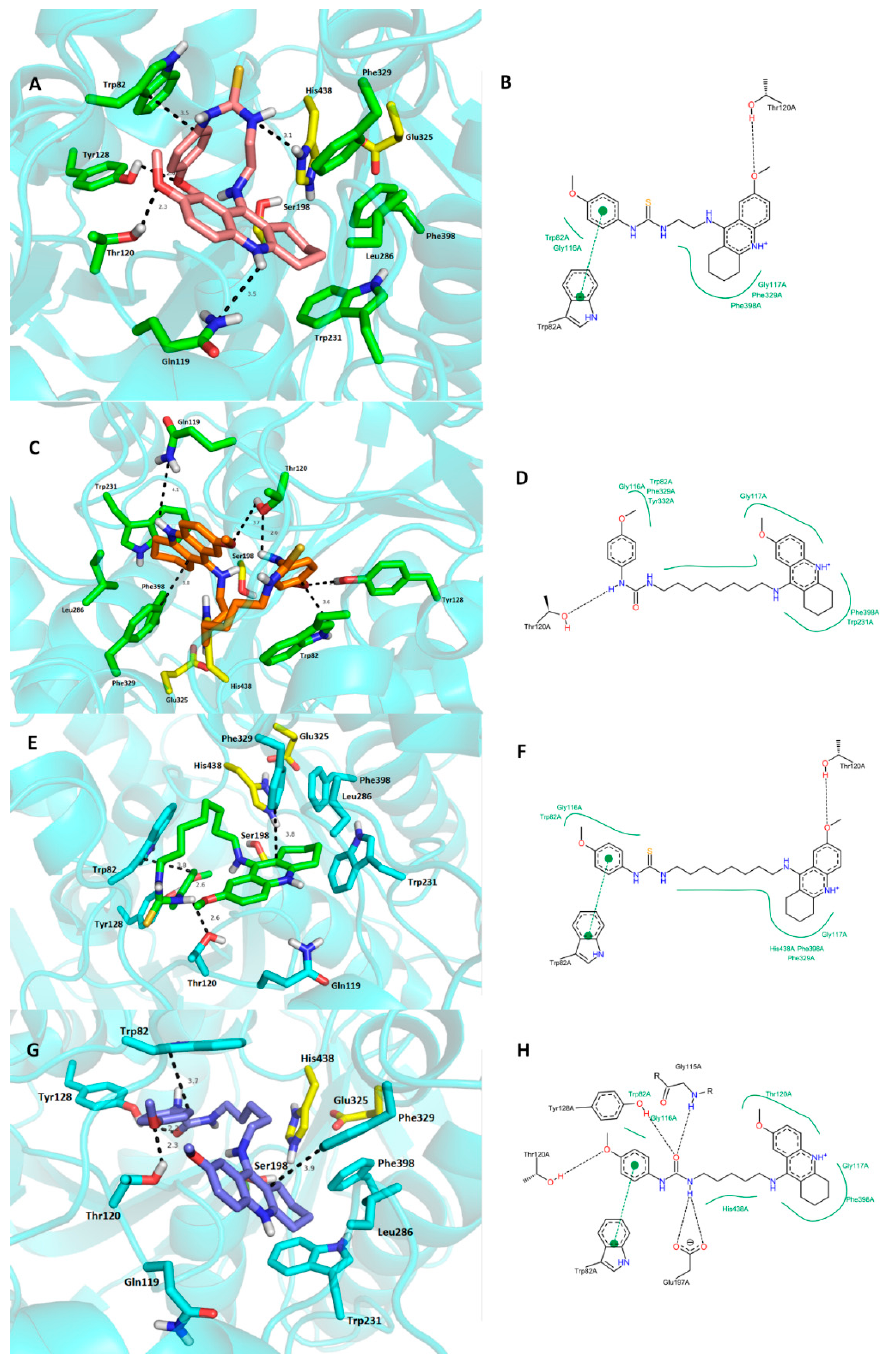
Figure 6 . Top scored docking poses for 9 , 22 , 15 and 19 in the h BChE (PDB ID: 4BDS) active site. ( A )—Superimposed analogue 9 (salmon pink carbon atoms); ( C )—spatial orientation of 22 (orange carbon atoms); ( E )—superimposed ligand 15 (green carbon atoms); ( G )—superimposed analogue 19 (dark blue carbon atoms). Generally to ( A , C , E , G )—important amino acid residues involved in the ligand-enzyme interactions are displayed as green carbon atoms ( A , E ) and as light blue carbon atoms ( E , G ), catalytic triad residues (Ser198, Glu325, His438) are shown in yellow, rest of the enzyme is represented as blue cartoon; ( B , D , F , H )—2D representation of binding modes of 9 , 22 , 15 and 19 , respectively. Figures ( B , D , F , H ) were created with PoseView software [43]; figures ( A , C , E , G ) were generated with PyMol 1.5.0.4 (The PyMOL Molecular Graphics System, Version 1.5.0.4 Schrödinger, LLC).